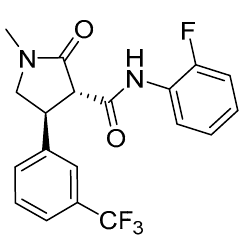
Figure 10. Structure of tetflupyrolimet, an aryl pyrrolidinone anilide targeting Dihydroorotate dehydrogenase, a key enzyme in pyrimidine biosynthesis.